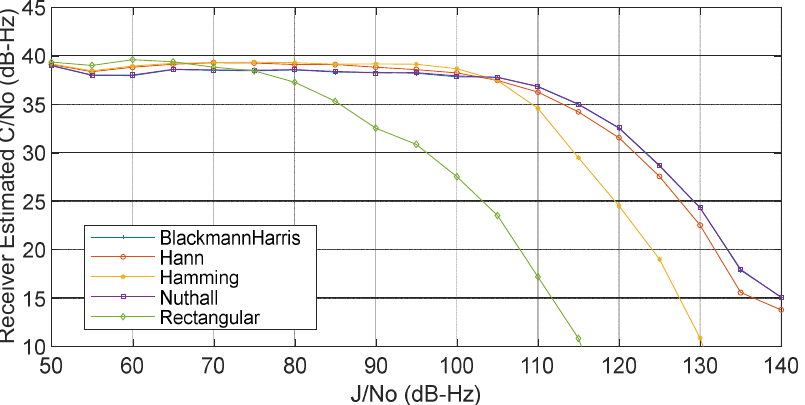
Figure 9. Effect of a single jammer on receiver estimated C/No (55 kHz from the centre frequency, PRN Doppler = 700 Hz) with different windowing functions.